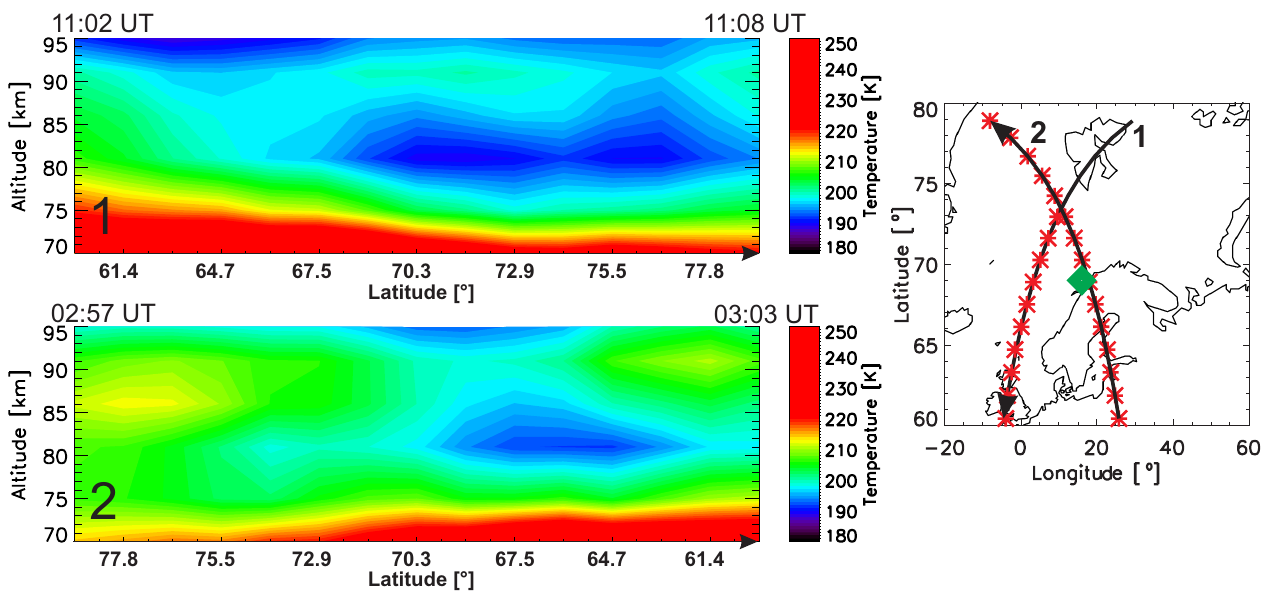
Fig. 3. Two transects of satellite MLS temperature measurements taken on 19 December 2010 over Scandinavia. For convenience transects are numbered both on plots and in the inset map with their direction denoted with arrows. Launch area is marked as an orange line on the lower plots and as green rectangle in the inset map. On the inset map parts of the transects over which MIL is observed are marked with red stars. Over each transect its start and end time is